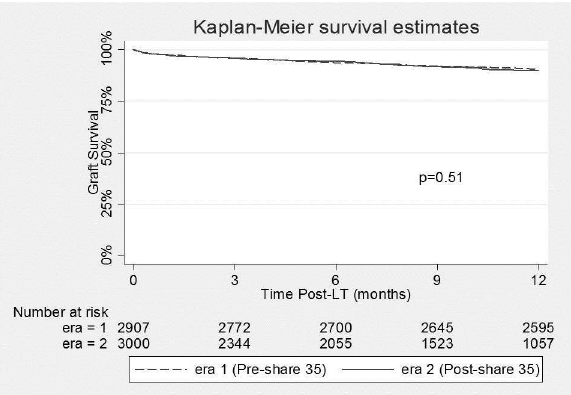
Fig 2. Graft survival in patients undergoing liver transplantation for hepatocellular carcinoma in Era 1 (Pre-Share 35) and Era 2 (Post-Share